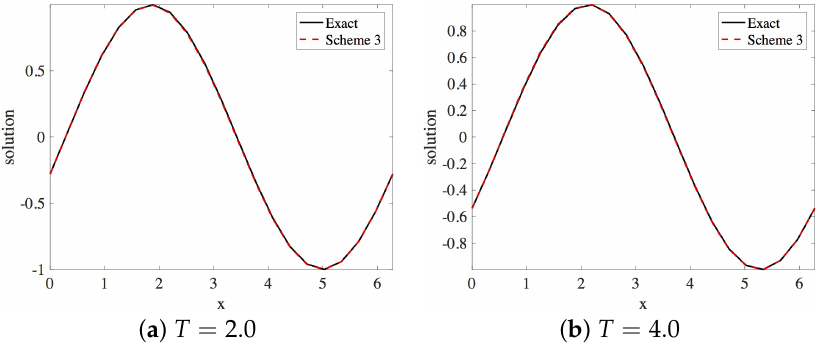
Figure 28. Plot of exact and numerical profiles (using Scheme 3) vs. x at times 2.0 and 4.0 using h = π /10 and k = 0.001 (Numerical experiment 2).